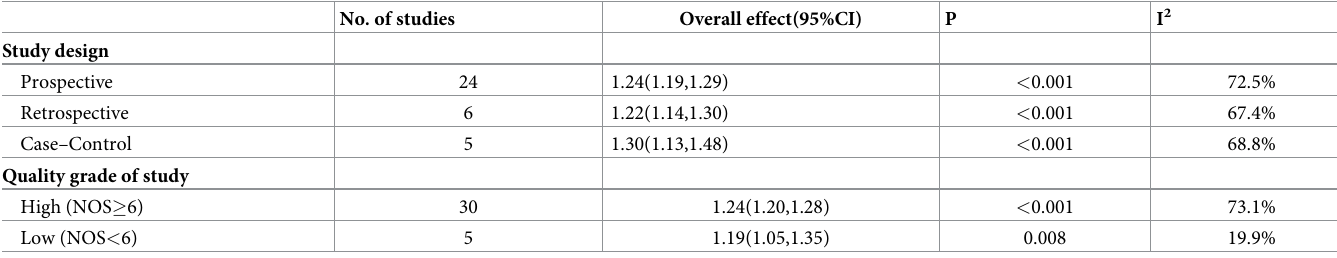
Table 4. Sensitivity analysis of the effects of maternal pre-pregnancy overweight and obesity on offspring mental health. No. of studies Overall